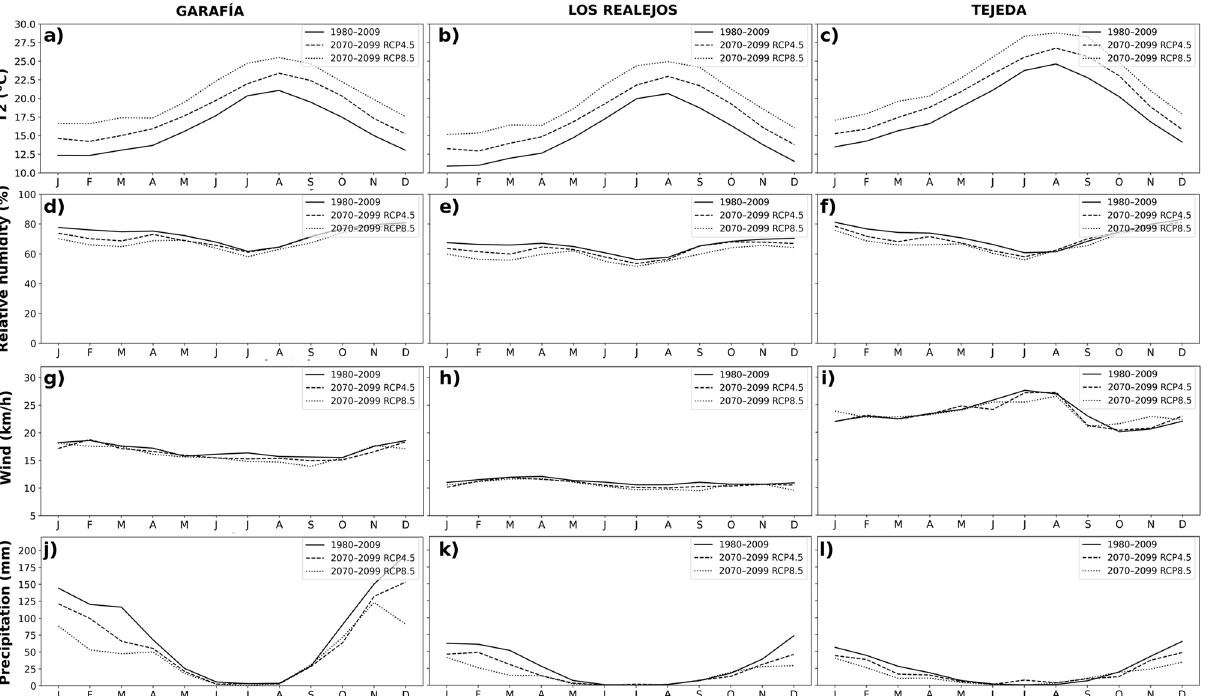
Figure 4. Monthly mean time series of 2 m temperature ( a , b , c ), 2 m relative humidity ( d , e , f ), 10 m wind speed ( g , h , i ) and accumulated precipitation ( j , k , l ), for the three selected locations and different 30 year periods simulations: recent past (1980–2009) and future (2070–2099), using scenarios RCP4.5 and 8.5.